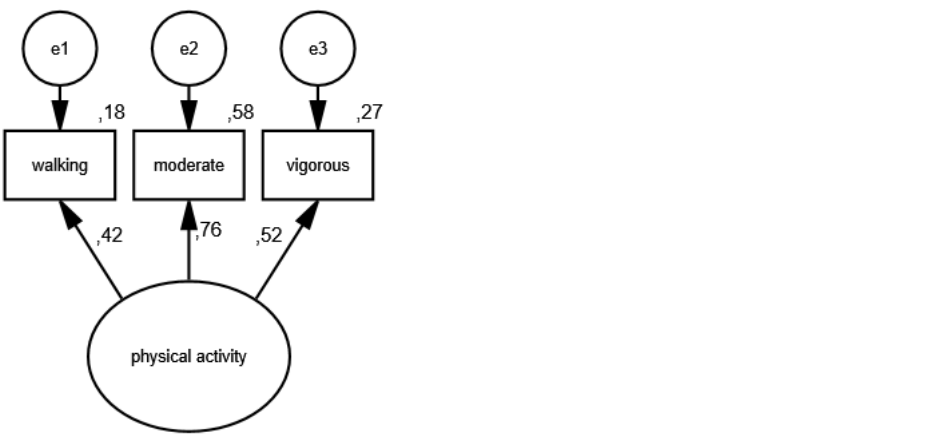
Figure 1. Standardized effects of the model of physical activity measurement in the group of women .